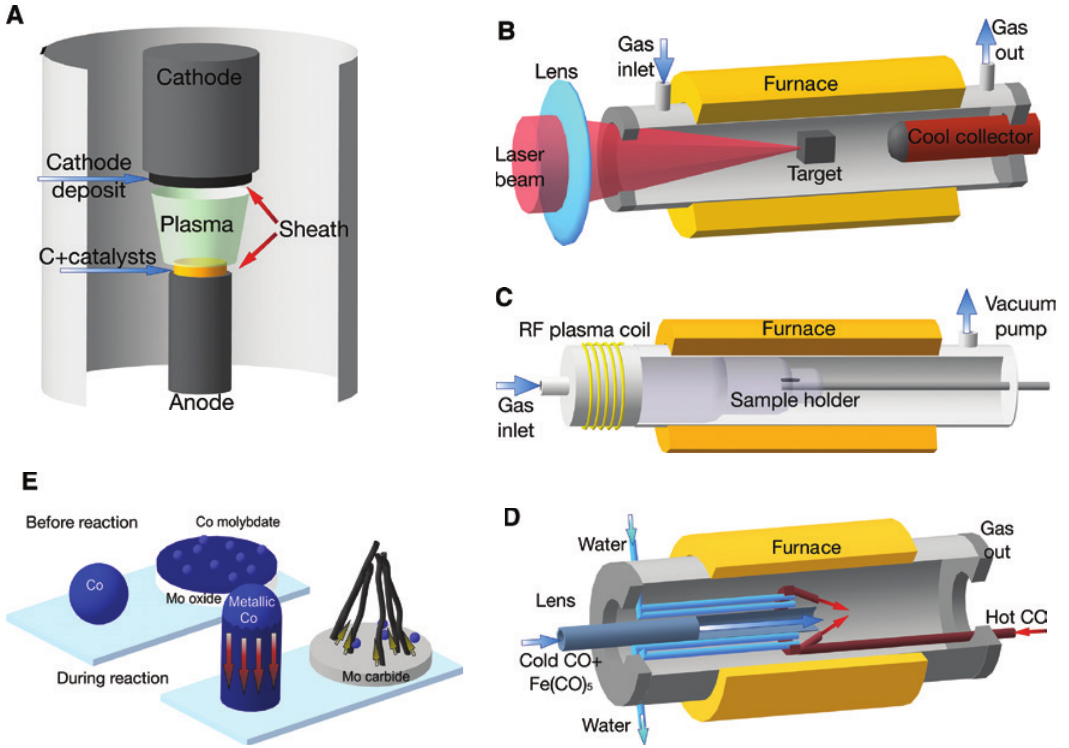
Figure 1: Schematic setup of CNT fabrication techniques: (A) arc-discharge process; (B) laser ablation; (C) CVD method; (D) HiPco process; (E) CoMoCAT technique. Adapted from